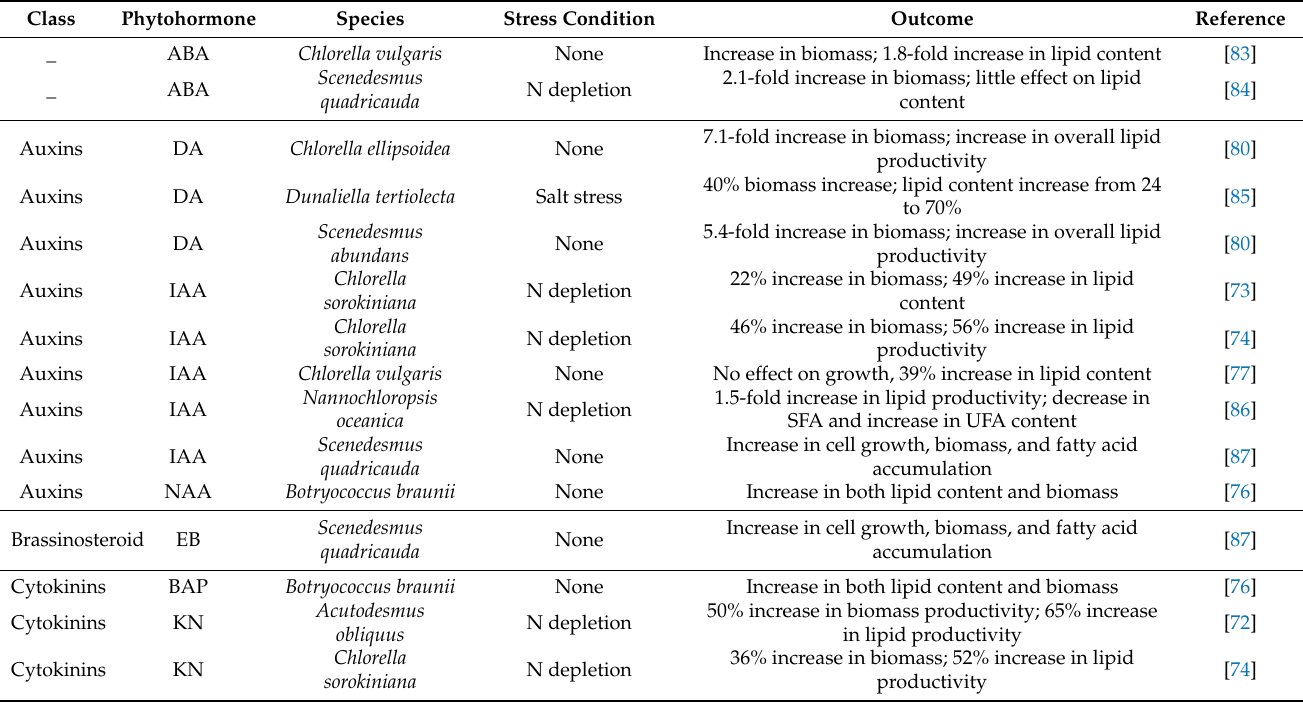
Table 1. Effect of phytohormones on microalgae lipids and